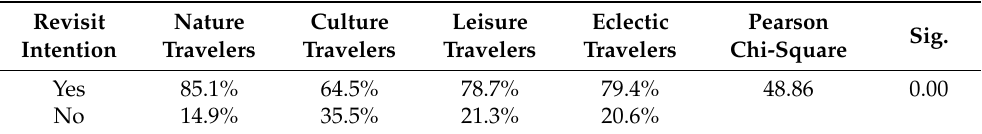
Table 9. The relationship between the visitor segments and the revisit intention. Revisit Nature Culture Intention Travelers Travelers